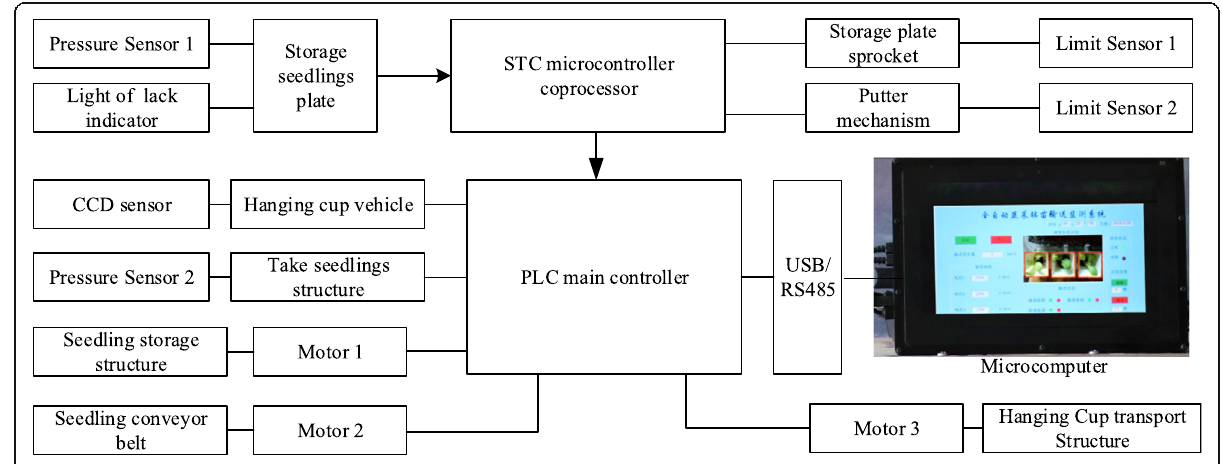
Fig. 3 Structure diagram of automatic conveying system for potted vegetable